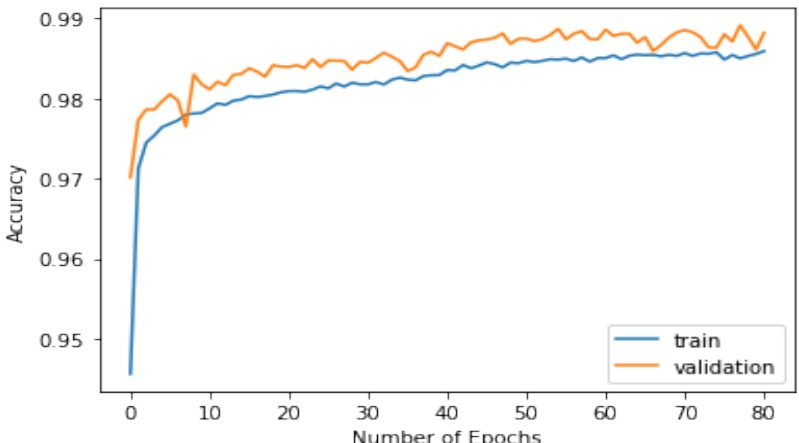
Figure 9. Model accuracy in training and validation phases in first